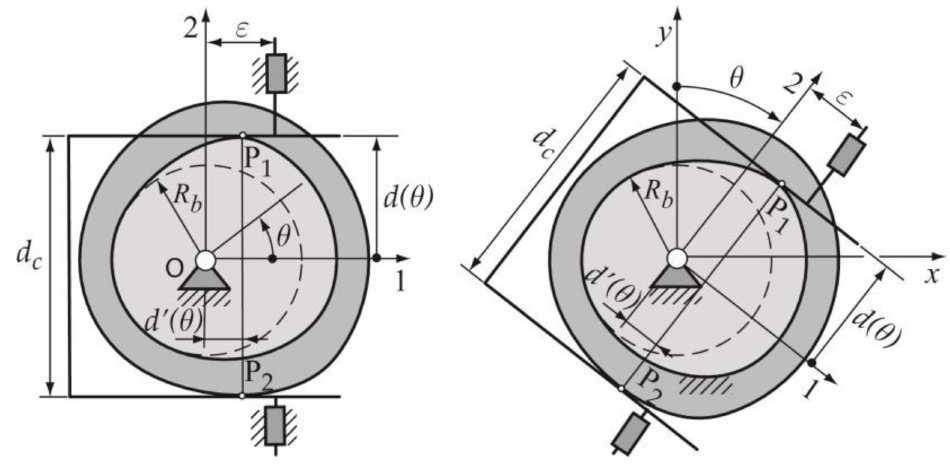
Figure 5. Conjugate cam mechanism and its kinematics